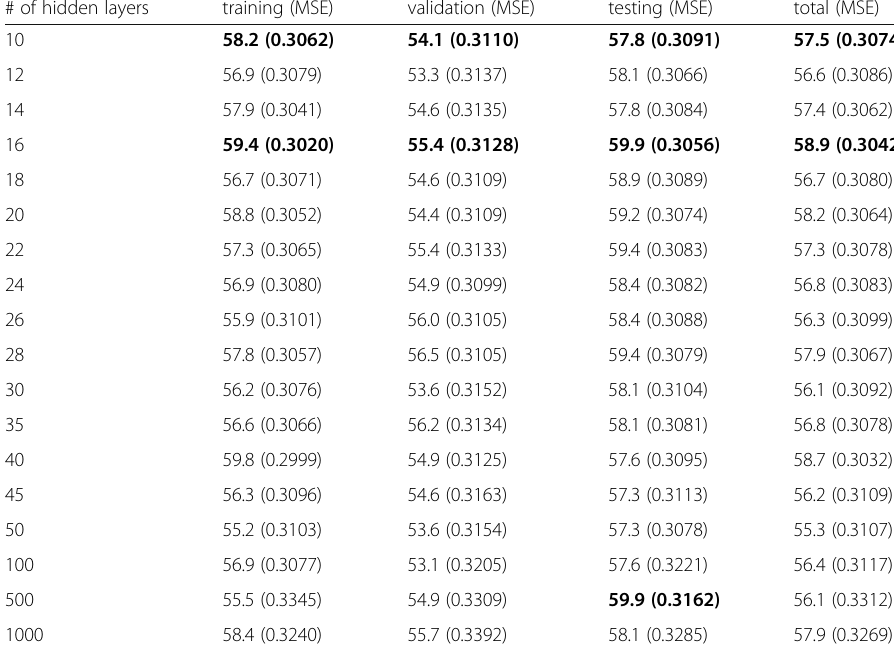
Table 3 Classification results with ANN/DNN classifiers using transformed data with PCs = 60 # of hidden layers